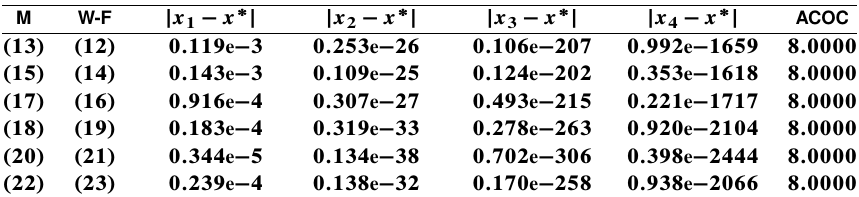
Table 3. Comparison for f.x/ D x 4 C sin . (cid:25) M